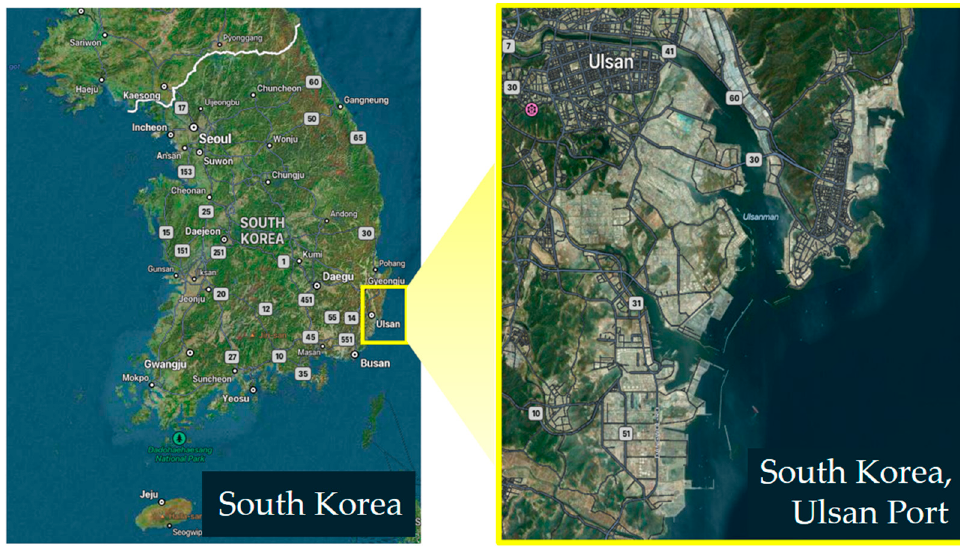
Figure 1. Ulsan Port—target site for congestion forecast.